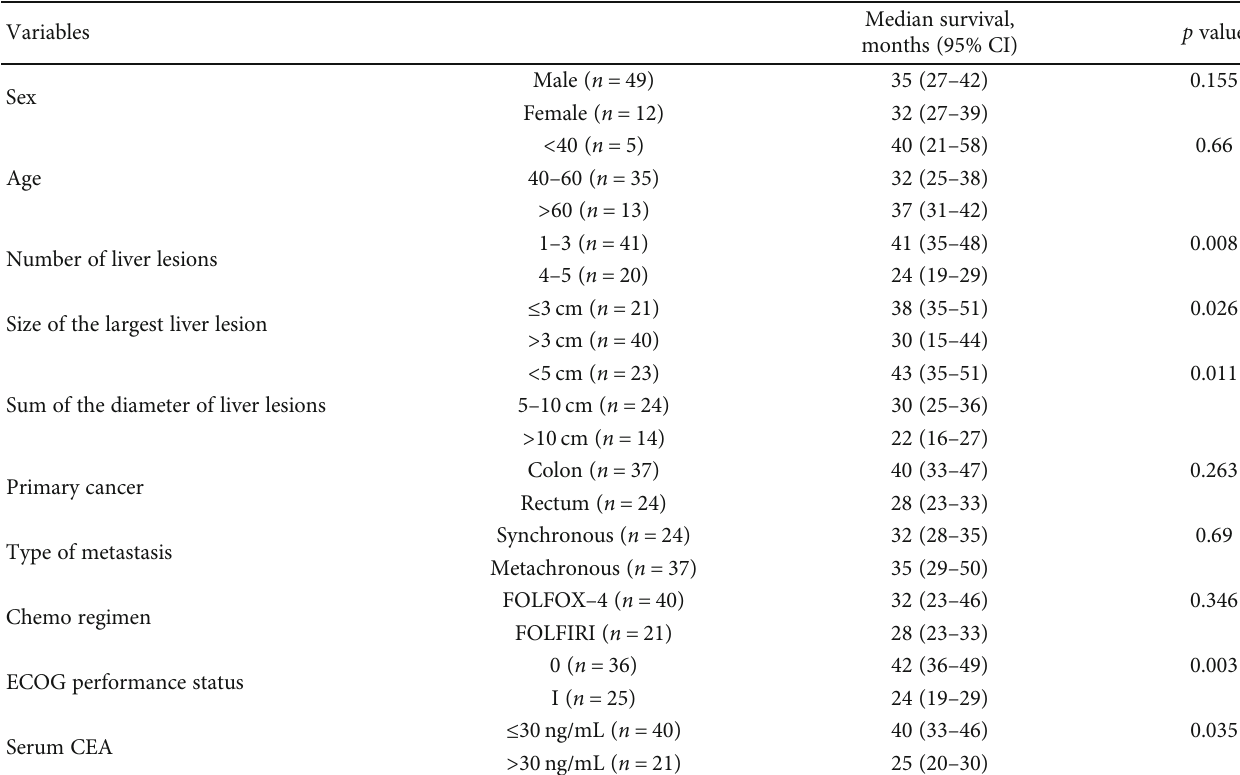
Table 2: Estimated survival times by potential prognostic